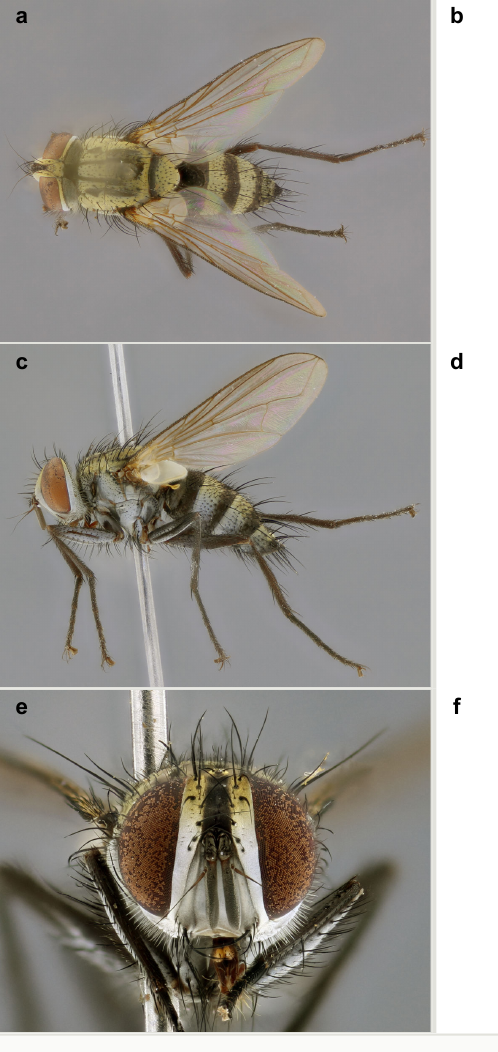
General morphology of Calolydella erasmocoronadoi sp. n. ; a–c : male holotype, voucher